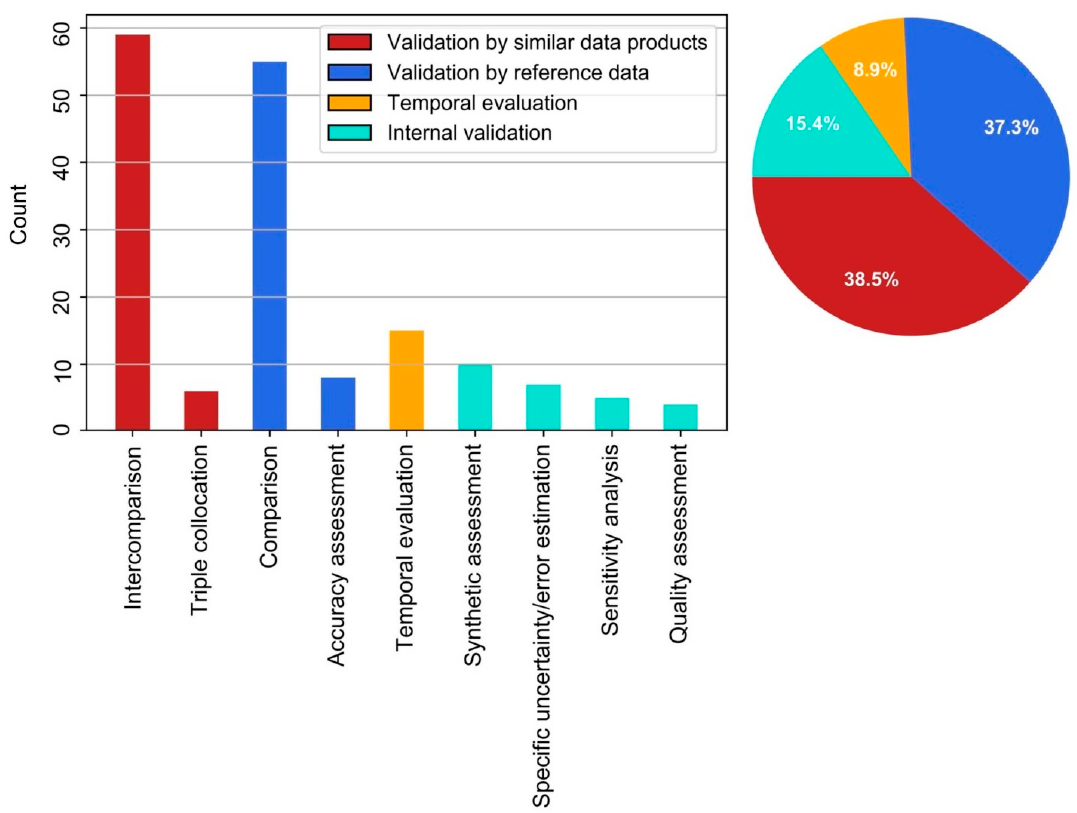
Figure 12. The number of applied validation methods categorized by the validation data source.